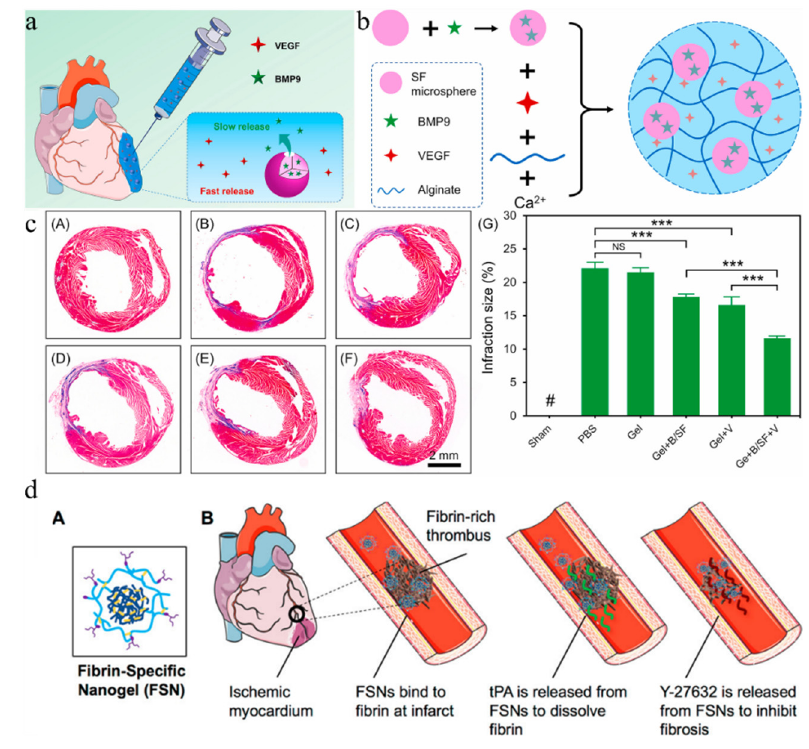
Figure 5. ( a ) Hydrogel-loaded BMP9 and VEGF in the treatment of myocardial infarction [159]. ( b ) Schematic of the preparation process of the composite hydrogel [159]. ( c ) Assessment of fibrosis in the infarct area 28 days post-MI and quantitative analysis of the infarction size as expressed by the ratio of infarct area to total left ventricular area. ( A – F ) Representative images of infarcted sections performed by Masson's trichrome staining. ( A ) Sham, ( B ) PBS, ( C ) Gel, ( D ) Gel + B/SF, ( E ) Gel + V, ( F ) Gel + B/SF + V. ( G ) Quantitative analysis of the infarction size as expressed by the ratio of infarct area to total left ventricular area. [159]. ( d ) ( A ) Fibrin-specific nanogel design. ( B ) drug-loading FSNs bind to fibrin at the site of infarction, releasing fibrinolytic drugs and small molecule cell contractile inhibitors to alleviate cardiac fibrosis (Reprinted with permission from Ref. [160]. 2018, American Chemical Society). Level of significance (***— p < 0.001, NS—not significant).